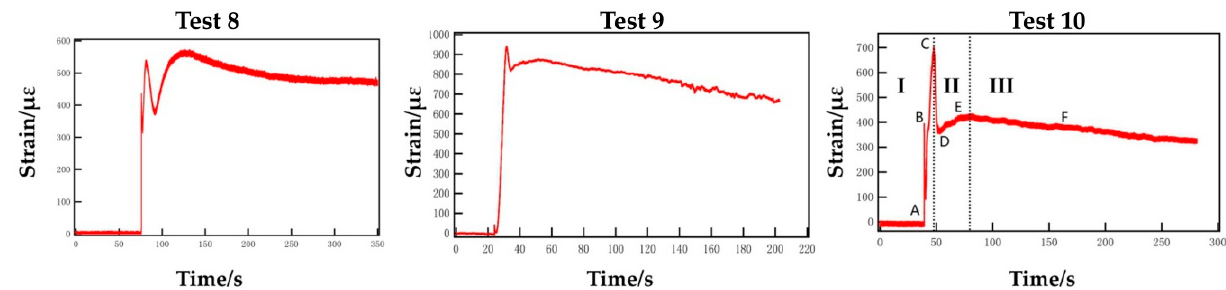
Figure 7. Strain–time curve of experiments 8, 9 and 10.